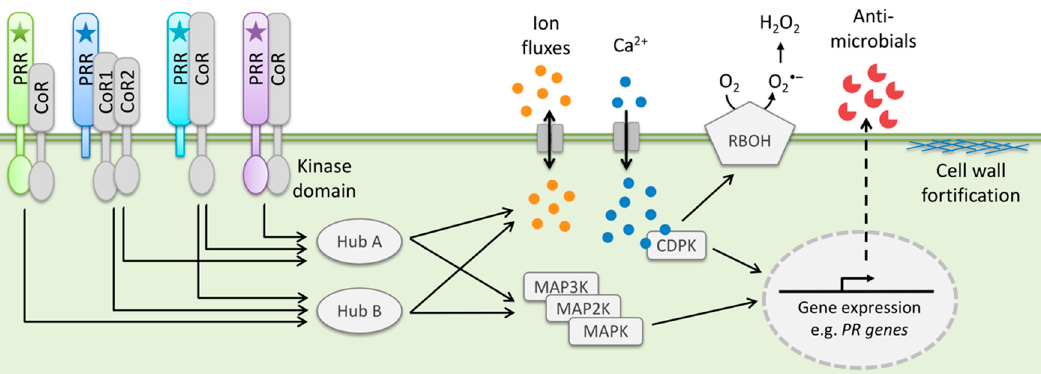
Figure 1. Scheme of typical MAMP and DAMP-activated immune responses in plant cells. MAMPs and DAMPs (star symbols) are sensed by specific host PRRs localized at the cell surface. Signaling pathways downstream of PRRs converge on common signaling components, for instance co-receptors (CoR) or signaling HUBS. PTI responses include for example fluxes of various ions—including the secondary messenger Ca 2+ —across the plasma membrane, production of ROS by RBOH-type oxidases, activation of calcium-dependent and mitogen-activated protein kinases (CDPKs and MAPKs), gene expression changes, production of antimicrobial compounds, and fortification of the plant cell wall.